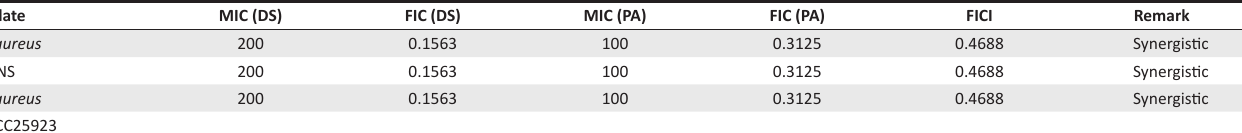
TABLE 1: Antibacterial susceptibilities and synergistic effects ( µ g/mL) of Diodia scandens and Phyllanthus amarus on selected staphylococci using microdilution method.